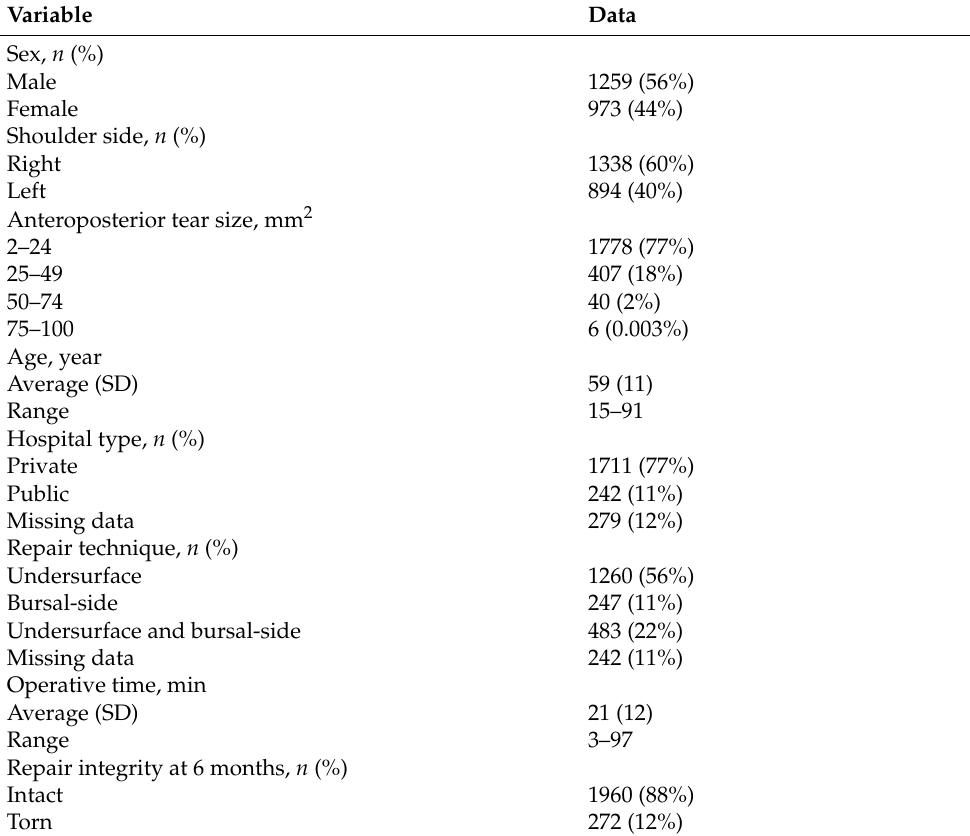
Table 1. Patient demographics.